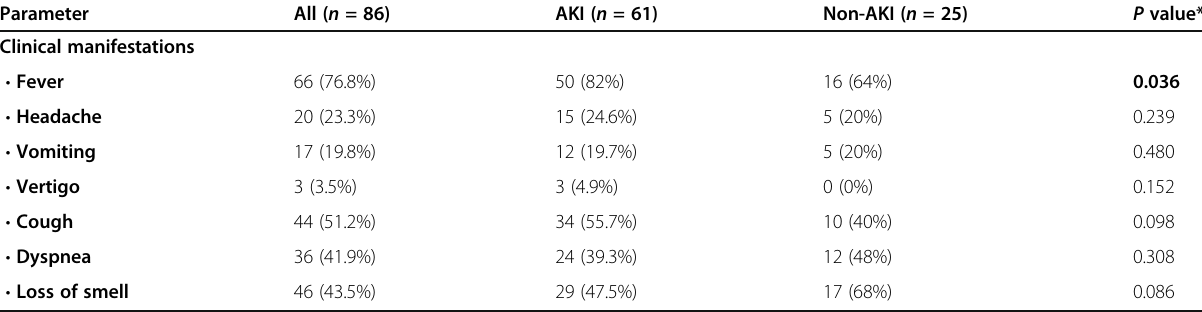
Table 2 COVID-19 symptoms and signs of the studied